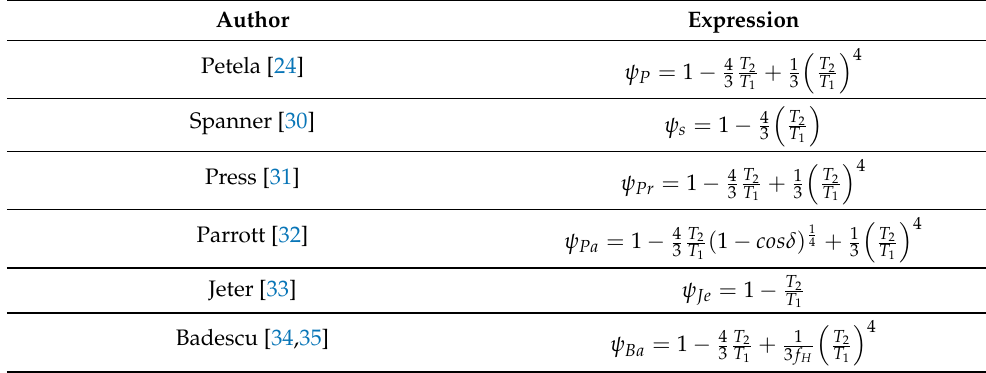
Table 1. Undiluted solar exergy models where ψ is the exergy factor.